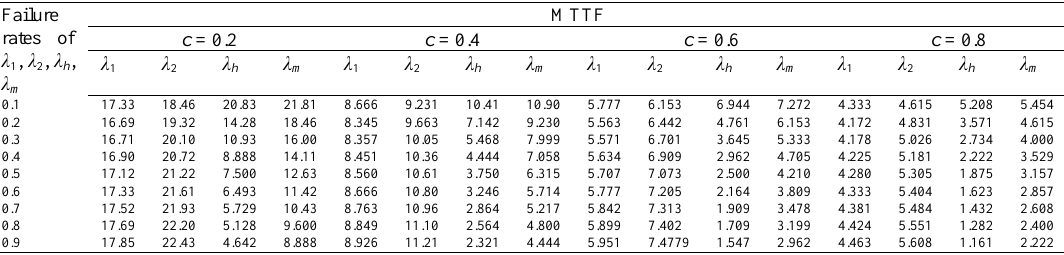
Table 12. MTTF of the system with